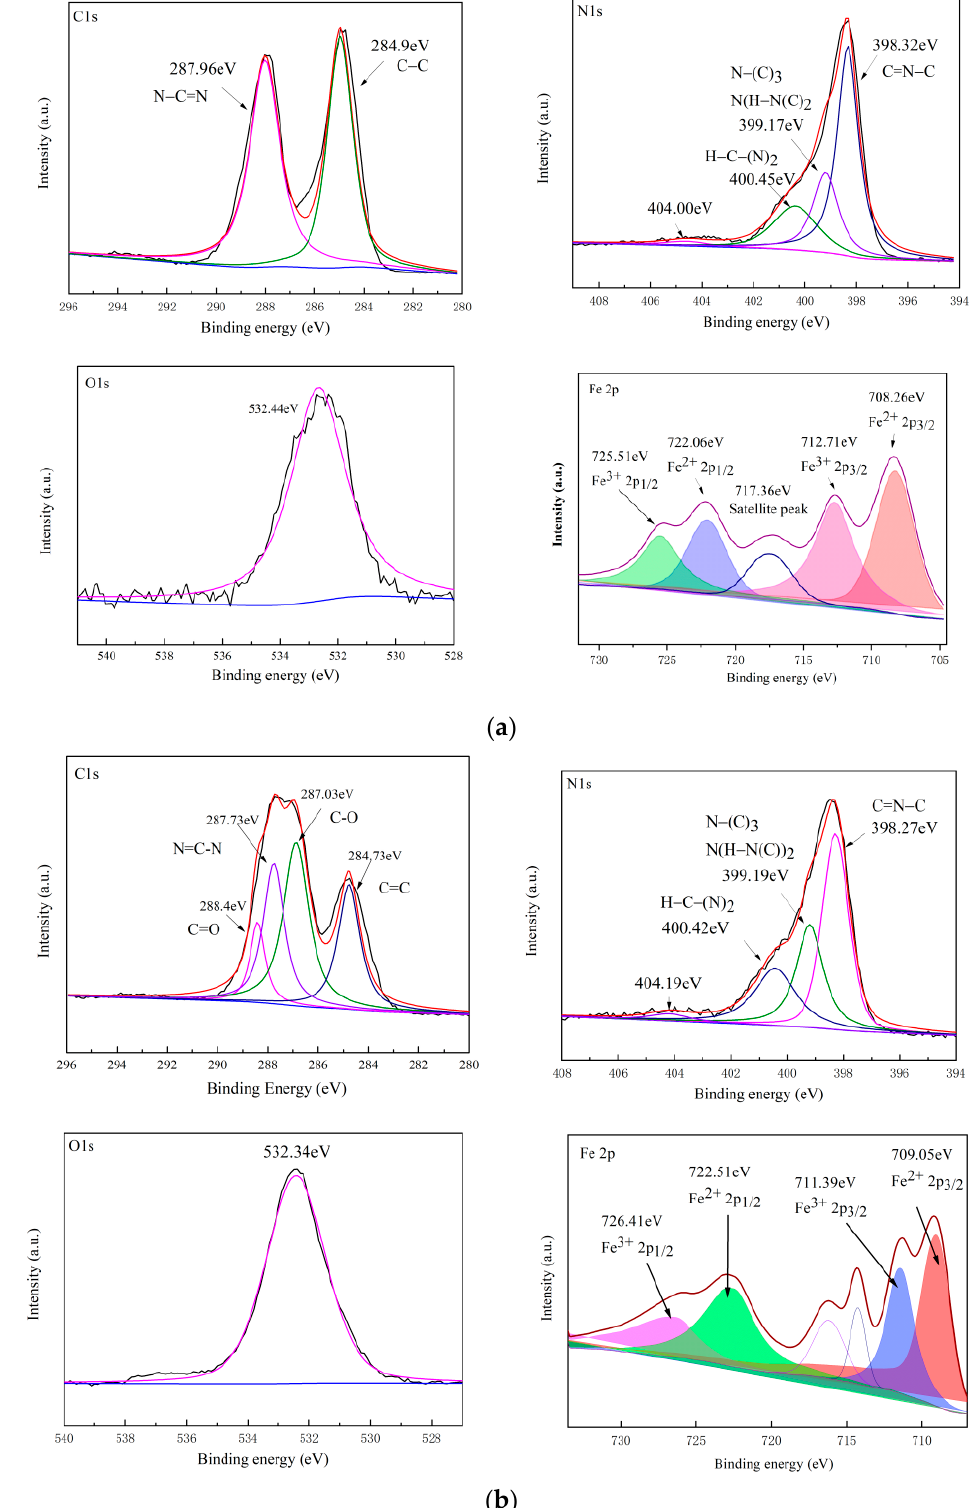
Figure 3. XPS patterns for Fe-GCN ( a ) and GO/Fe-GCN ( b ): high-resolution C 1s, N 1s, O 1s, and Fe 2p spectra. 2p